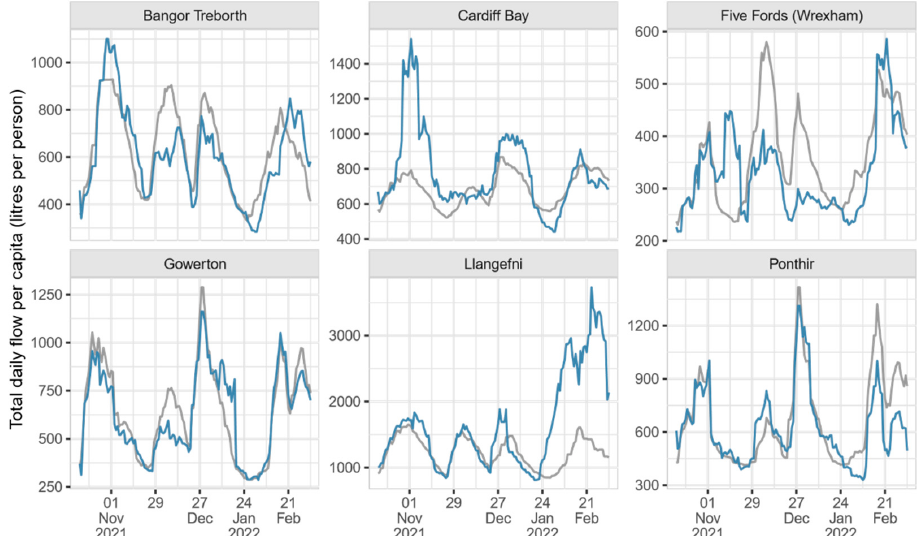
Figure 3. Time series for observed daily flow (in grey) and estimated daily volume (in blue) per capita at six wastewater treatment sites in Wales. The time series covers a 21-week period up to 7 March 2022 at each site. Each plot shows a 10-day, right-aligned rolling average for each measure. Note there are different y -axis scales for each site.